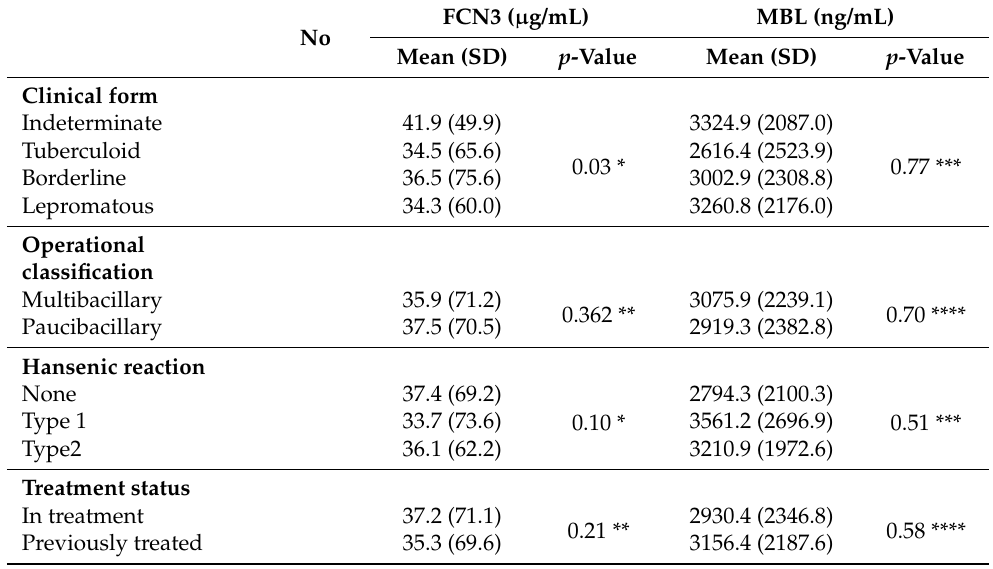
Table 3. Association between FCN3 and MBL serum concentrations and clinical factors in leprosy